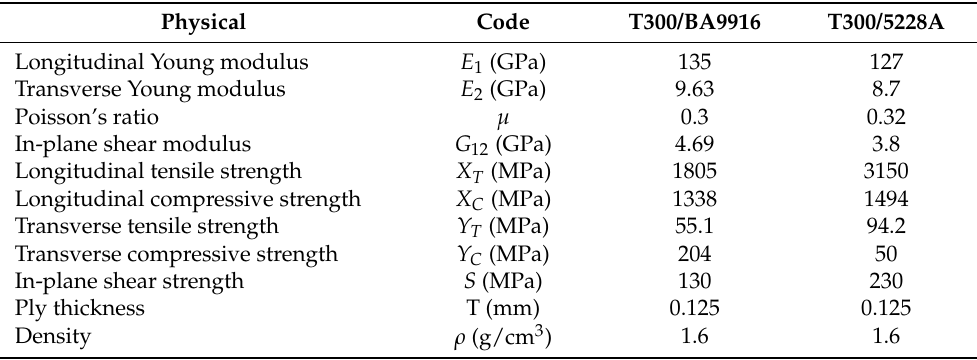
Table 3. Material properties of the unidirectional lamina.